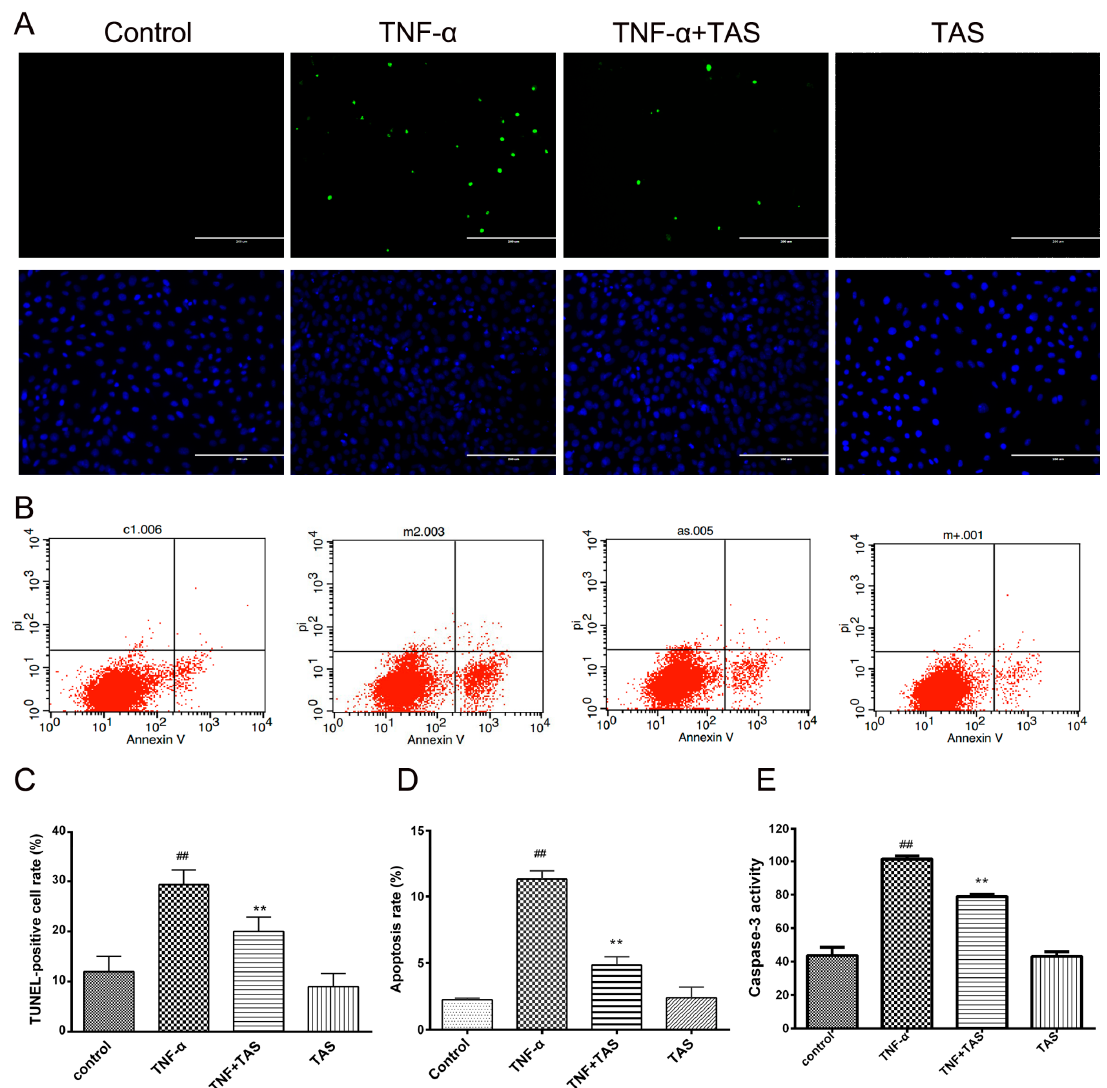
Figure 5. TAS suppressed TNF- α -induced apoptosis . HUVECs were preincubated with TAS (5 µ g/mL) for 2 h, followed by treatment with TNF- α (50 ng/mL) for 24 h. HUVEC apoptosis was assessed by ( A ) TUNEL staining and ( B ) annexin V/propidium iodide (PI) staining. ( C ) Quantitative analysis of the ratio of TUNEL-positive cells. ( D ) Quantitative analysis of the ratio of apoptotic cells. ( E ) Cells were preincubated with TAS (5 µ g/mL) for 2 h, followed by treatment with TNF- α for 24 h. Caspase-3 activity was examined with a fluorescent labelling kit using a microplate reader. The data are expressed as the mean ± SD of three independent experiments. ## p < 0.01 versus the control group; ** p < 0.01 versus the TNF- α -incubation group. Scale bars, 100 µ m.